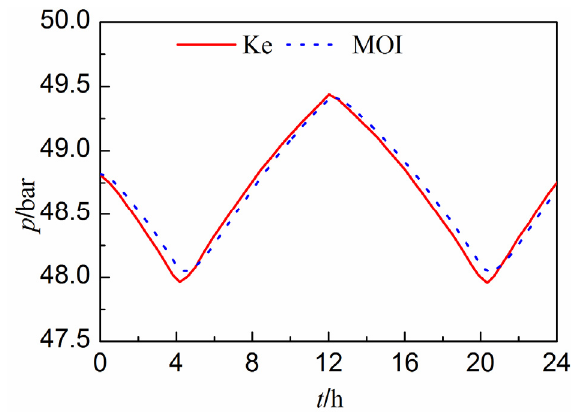
Figure 10. Pressure traces at Node 2.